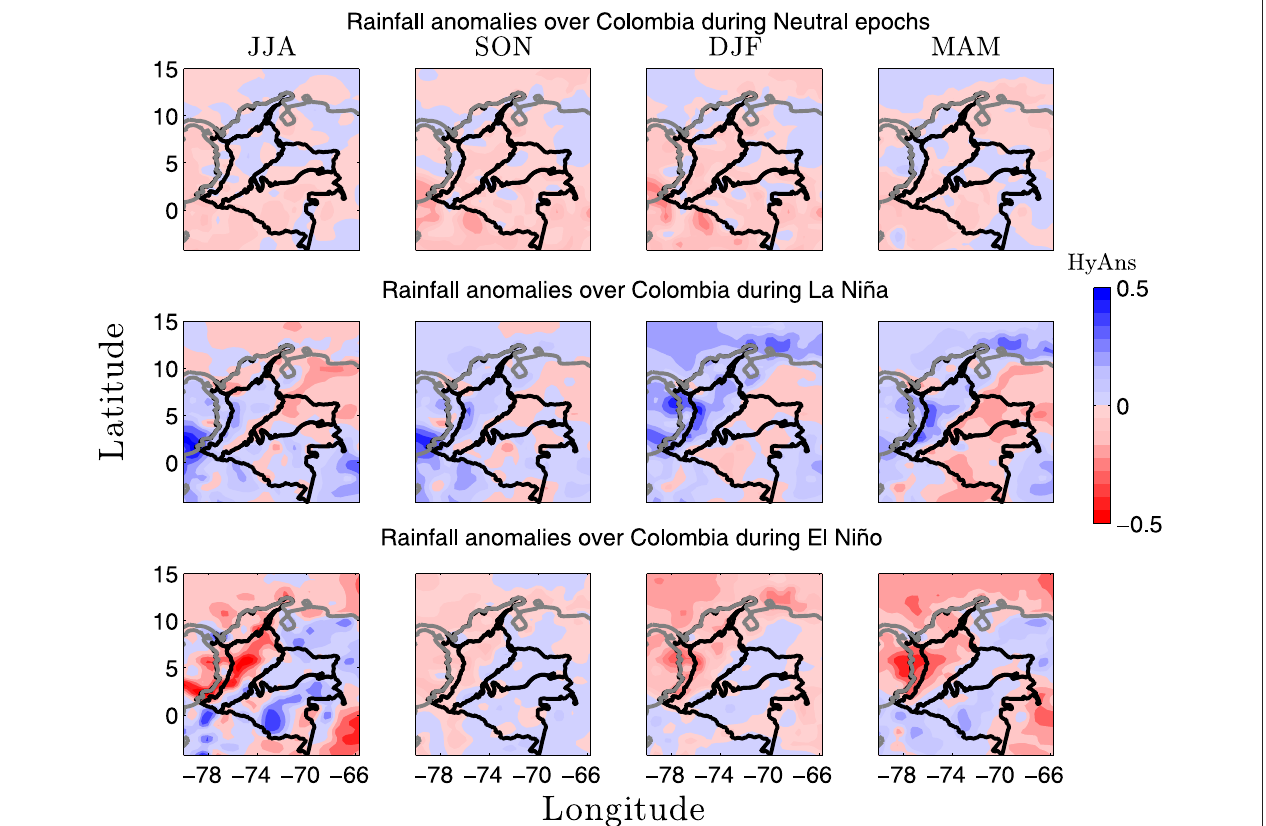
FIGURE 4 | Seasonal average rainfall anomalies (HyAns) in Colombia during ENSO. Data set No. 1. Rainfall anomalies were calculated using F-Filtering of the annual cycle by moving averages, which is previously mentioned as the HyAns–FAC method. (Gray line) Northern South American coast line. (Black line) Borders of the Colombia’s natural